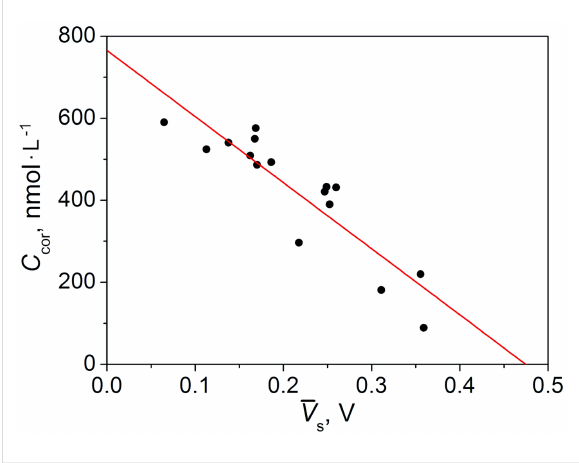
Figure 4: Dependence of the analytical concentration of cortisol C cor on the average response voltage in the area of the maximum corre- lation. Black dots correspond to the data from the medical tests and the red line is the result of the linear approximation, given by Equation